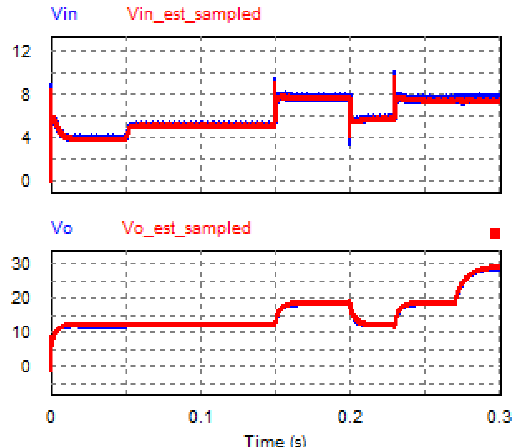
Figure 9. Input and output voltages. Actual (blue) and Reconstructed (red).